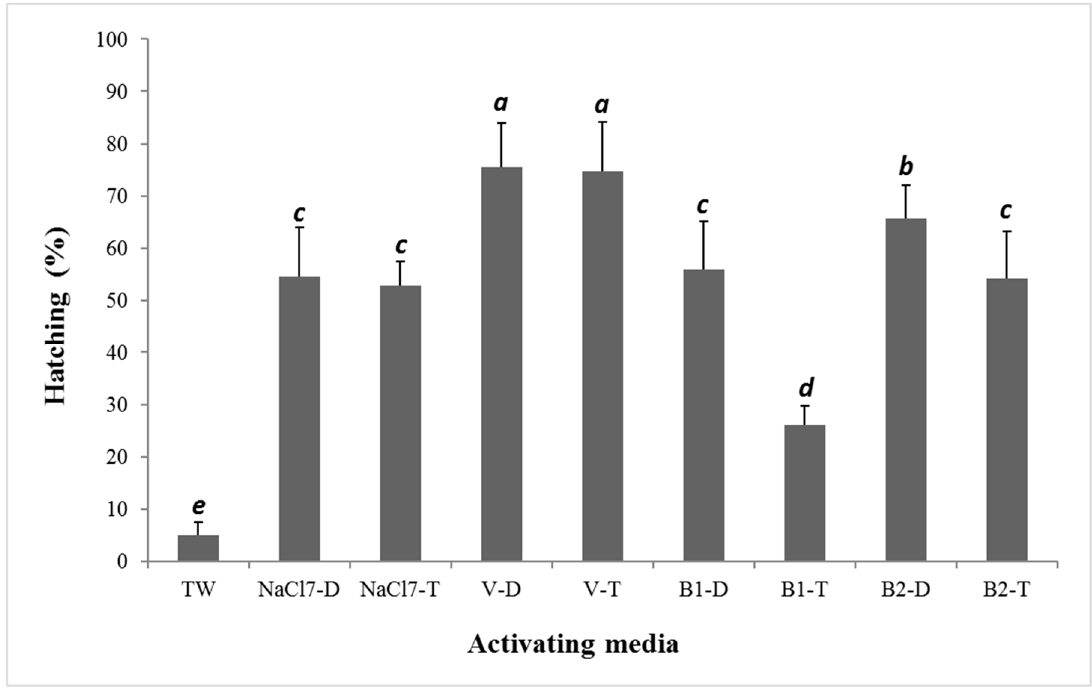
Figure 2. Hatching rates (%) of northern pike ( Esox lucius ) embryos in different activation media used for fertilization in experiment 2. Data are means ± SD. Values with different letter indices differ significantly (Tukey’s multiple range tests at p < 0.05). Table 3. Hatching rates with different activation media at different field hatcheries. Data are means ± SD. Values in columns with different letter indices differ significantly (Tukey’s multiple range tests at p < 0.05).